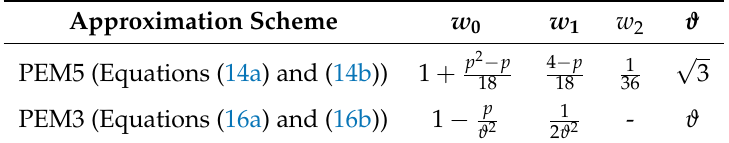
Table 1. Weights and spread parameter of the PEM for a standard Gaussian distribution